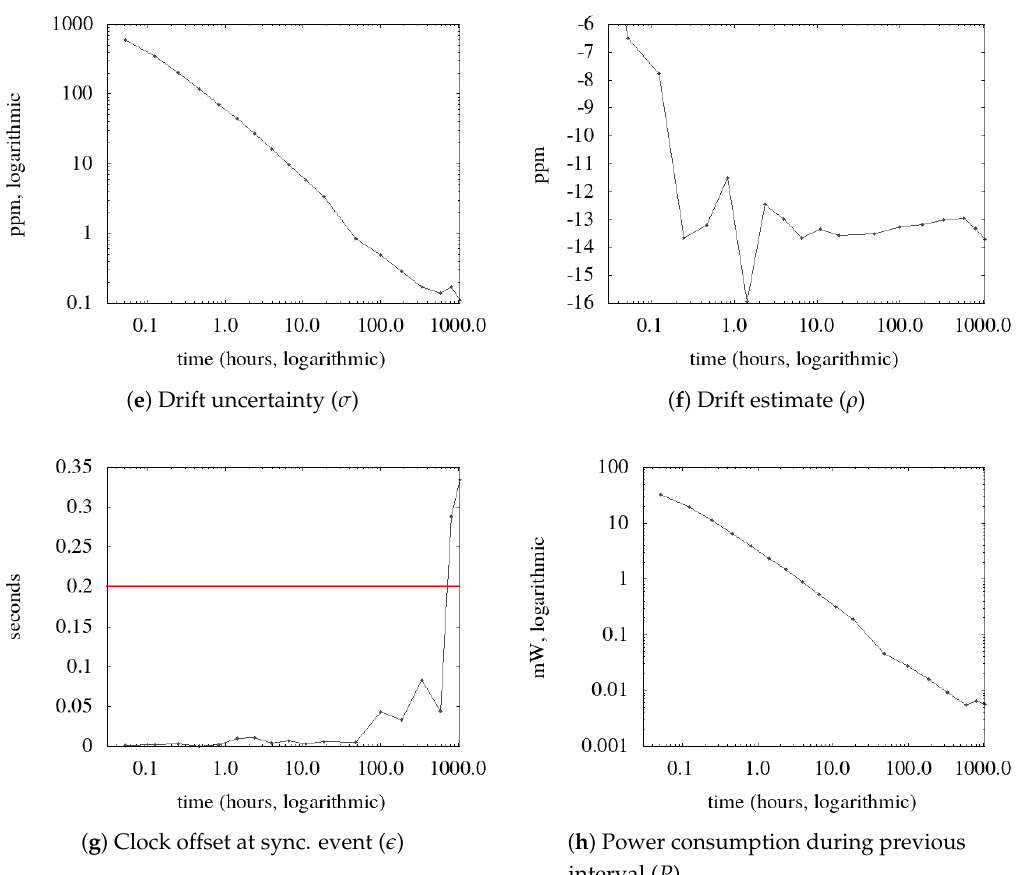
Figure 4. Results of the experiment using an undocumented branded clone of the Arduino Uno. Clock uncertainty ( c ) diverges and exceeds the threshold (in red), after 590 h (24 days). The reason is that drift variation ( b ) during such periods exceeds drift uncertainty ( a ), around 0.15ppm because of clock instability. We conclude that a threshold σ min = 0.15 ppm is a lower bound of drift uncertainty for this board, with an associated power consumption ( d ) of